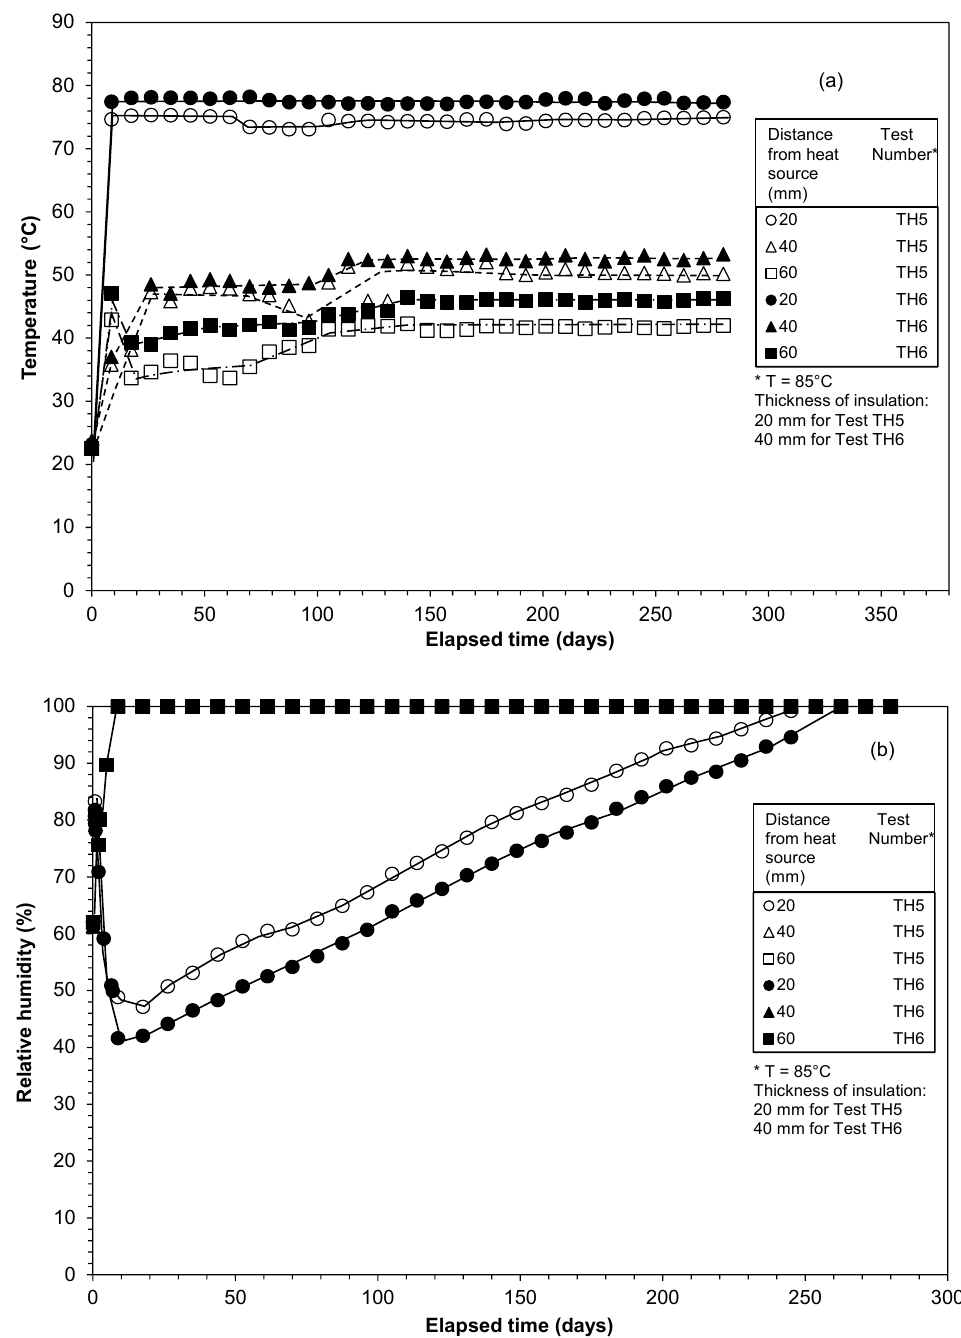
Figure 8. Effects of simultaneous application of thermal and hydraulic gradients (85 °C, bottom; 25°C, top; and water pressure from top = 600 kPa) on the distributions of: ( a ) temperature; ( b ) relative humidity in compacted bentonite specimens (diameter 100 mm, height 80 mm).